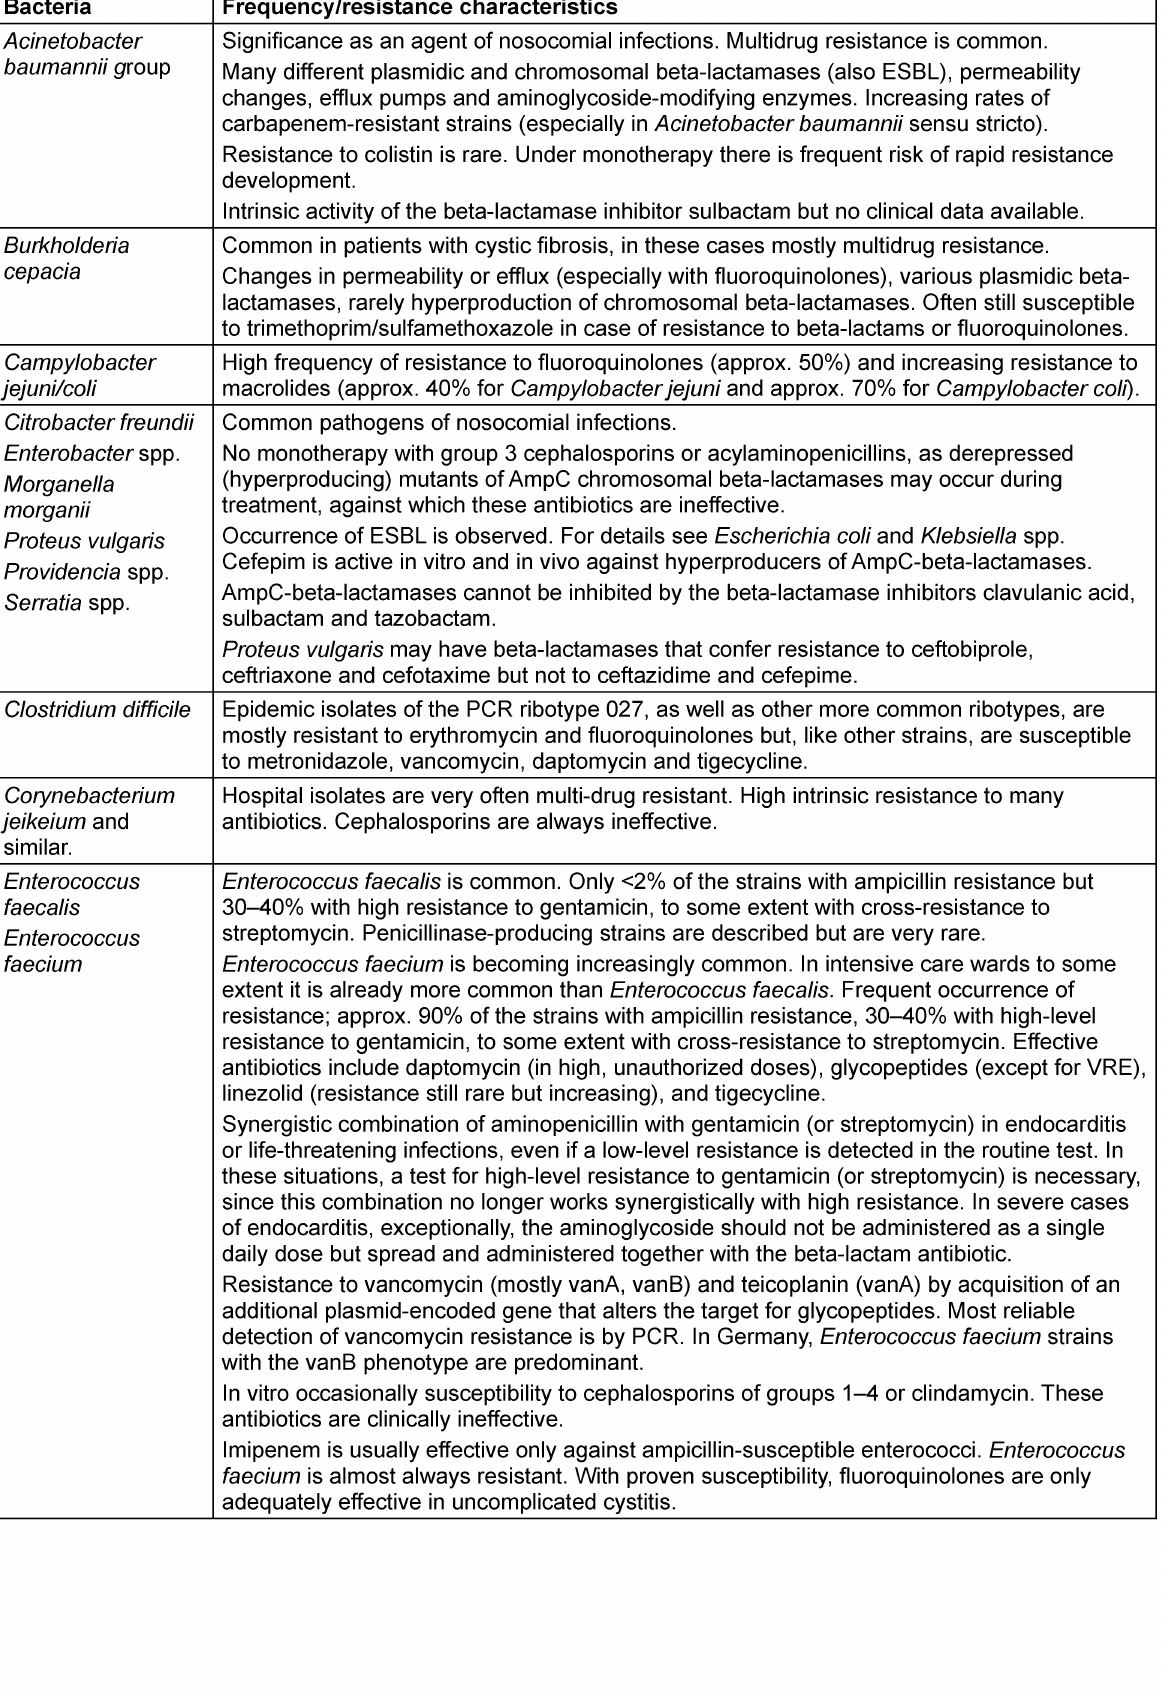
Table 2: Information on the resistance situation in important bacterial